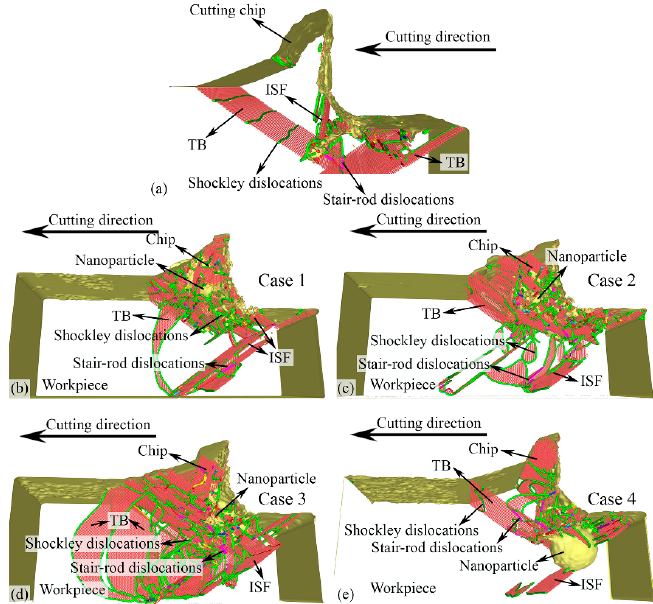
Figure 3. Snapshots of the defects in the subsurface of the workpiece with no NPs ( a ), with NP for Δ